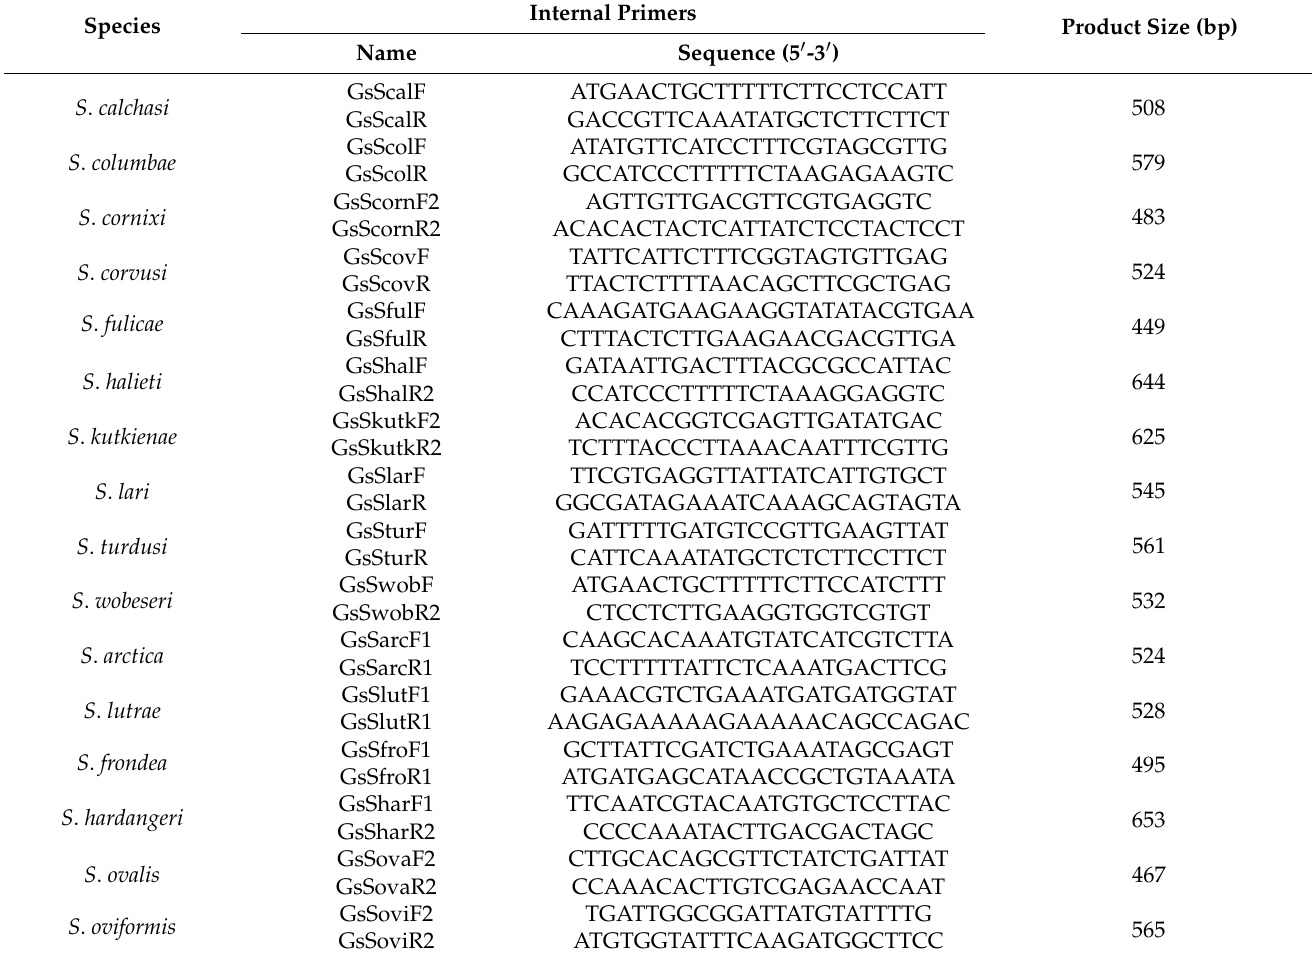
Table 1. The internal primers used for the nPCR of selected Sarcocystis